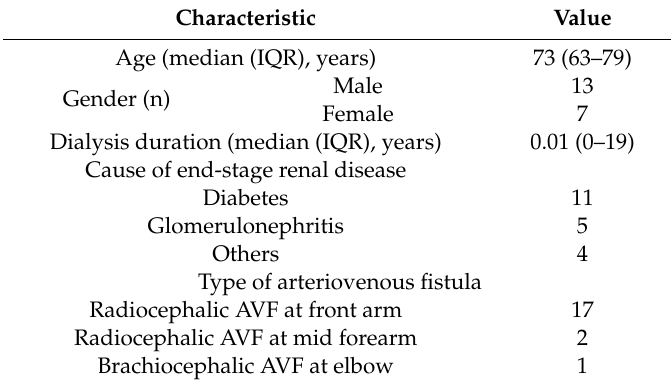
Table 1. Sociodemographic and clinical characteristics of the 20 participants. Participants included patients between the ages of 49 and 90 with various